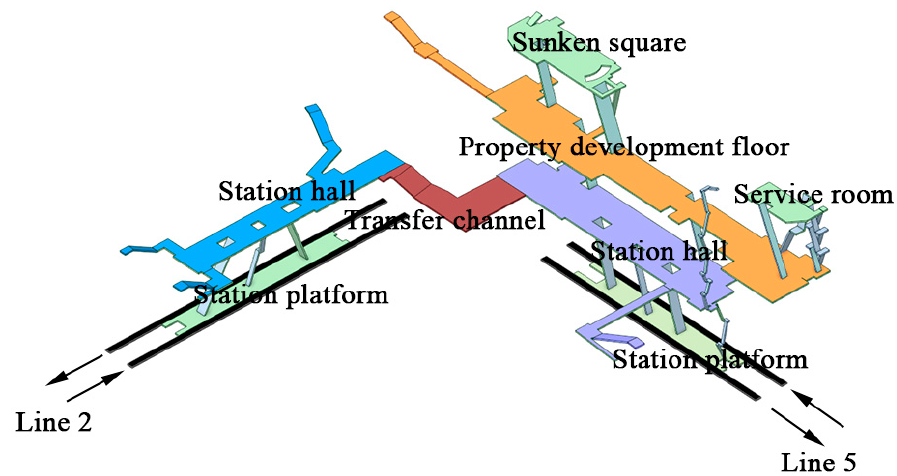
Figure 4. Schematic diagram of the floors of the target study station.